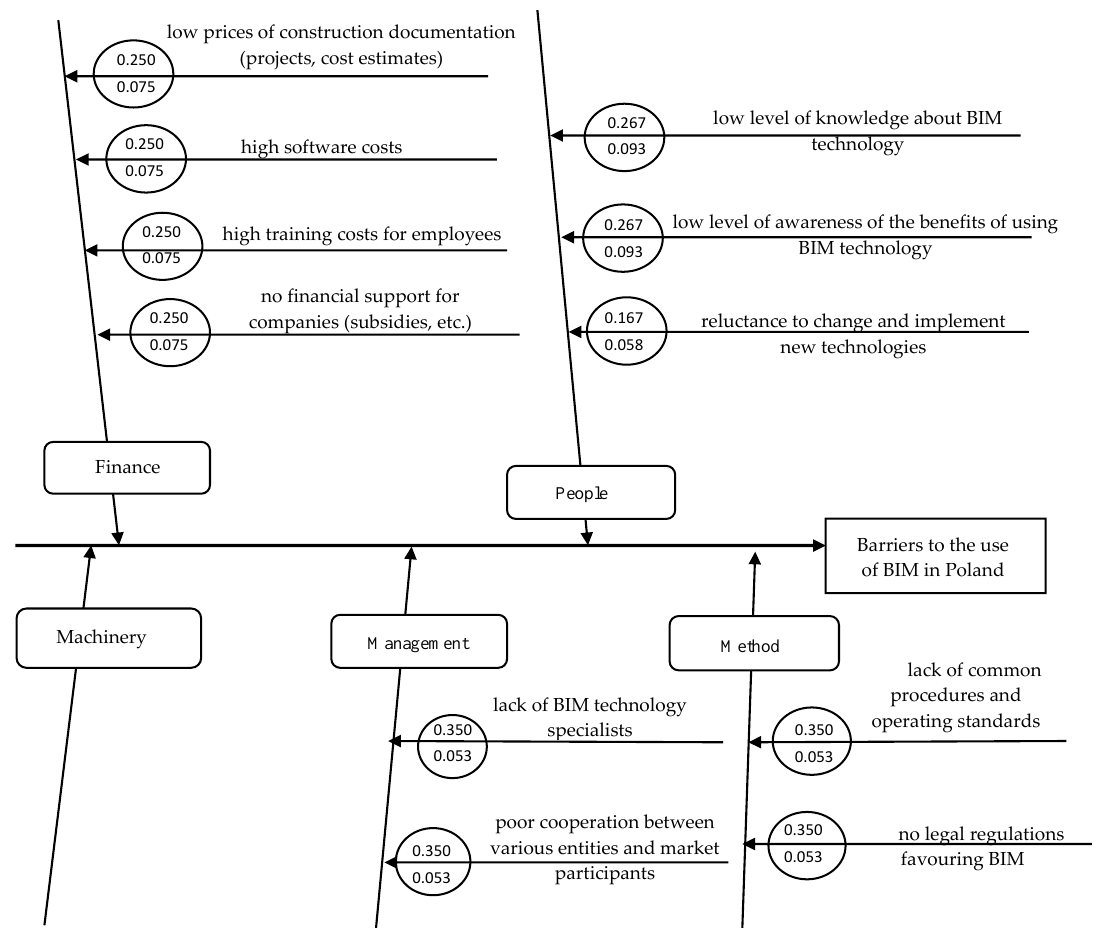
Figure 11. Ishikawa diagram: barriers to the application of BIM in Poland.